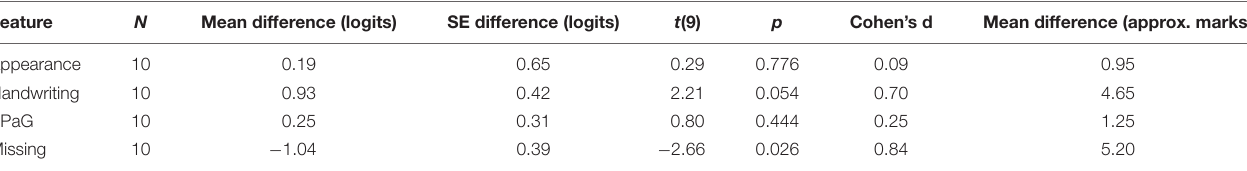
TABLE 3 | Paired t -test results for the four